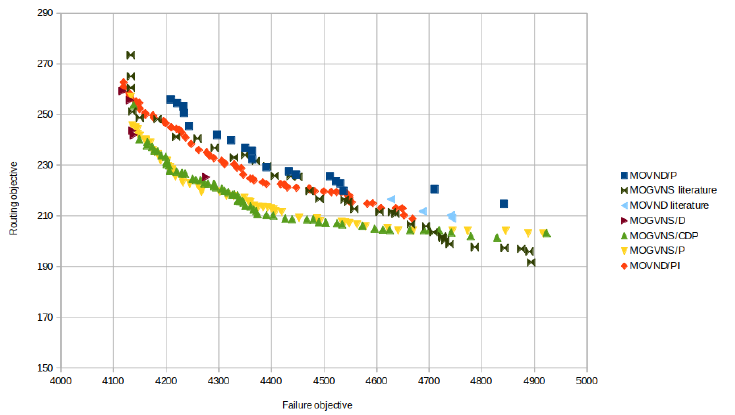
Figure 3. Pareto fronts of the different algorithms for the instance C201/25/18/100/200/0.30 and the failure cost as second objective (52